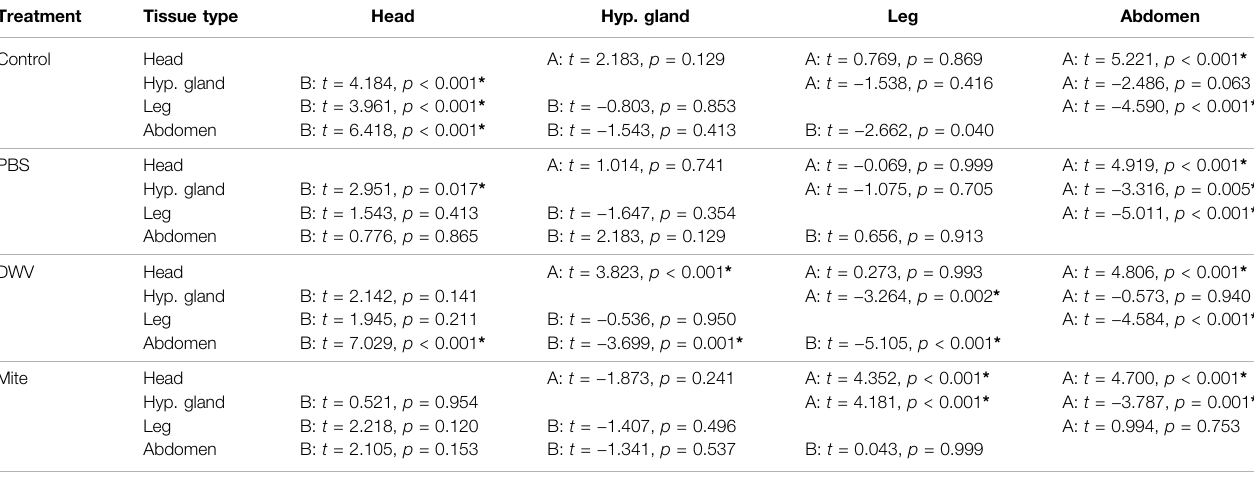
TABLE 2 | Tissue-type contrasts. Post hoc contrasts comparing DWV-A (A) and DWV-B (B) levels among tissue types [head, hypopharyngeal gland (hyp. gland), rear leg (leg), and abdomen] for each treatment [naturally occurring infection (control), PBS injection, DWV injection and Varroa mite exposure (mite)]. Statistical signi fi cance is also indicated by “ * ” .